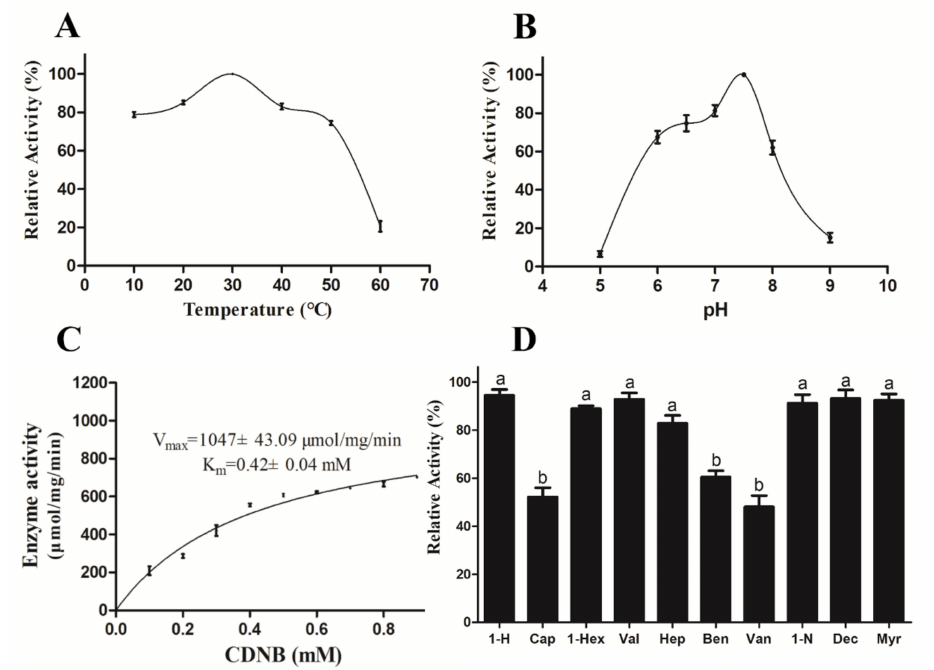
Figure 4. Enzymatic properties of recombinant SzeaGSTd1. ( A ) Relative activity of recombinant SzeaGSTd1 at different temperatures. ( B ) Relative activity of recombinant SzeaGSTd1 at different pH levels. ( C ) The enzyme kinetic properties of recombinant SzeaGSTd1 to CDNB. ( D ) Effect of host plant volatiles on recombinant SzeaGSTd1. 1-H: 1-Hexanol; Cap: capryl alcohol; 1-Hex: 1-Hexadecanol; Val: Valeraldehyde; Hep: Heptaldehyde; Ben: Benzaldehyde; Van: Vanillin; 1-N: 1-Nonanal; Dec: Decanal; Myr: Myrcene. Error bars represent mean ± S.D. of three independent experiments conducted in three replicates. Different letters on the error bars indicate significant differences identified by ANOVA and HSD tests ( p < 0.05).